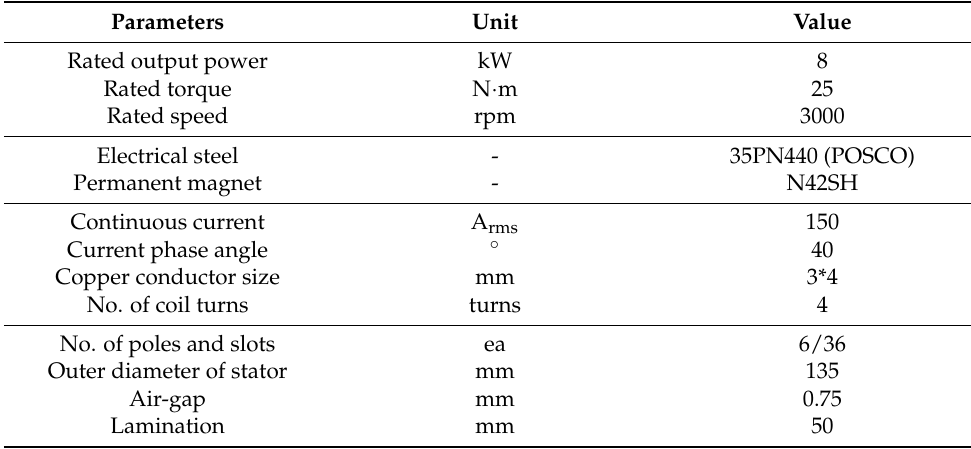
Figure 1. Shape of the initial model of the permanent magnet synchronous motor (PMSM). Table 1. Specifications of the initial model of the